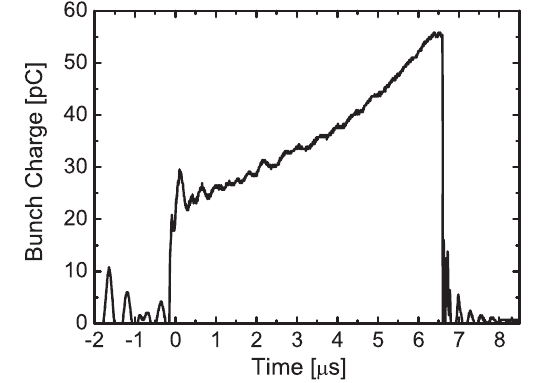
FIG. 5. Typical temporal evolution of the electron bunch charge during a macropulse.